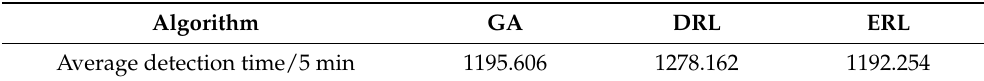
Table 1. Algorithm